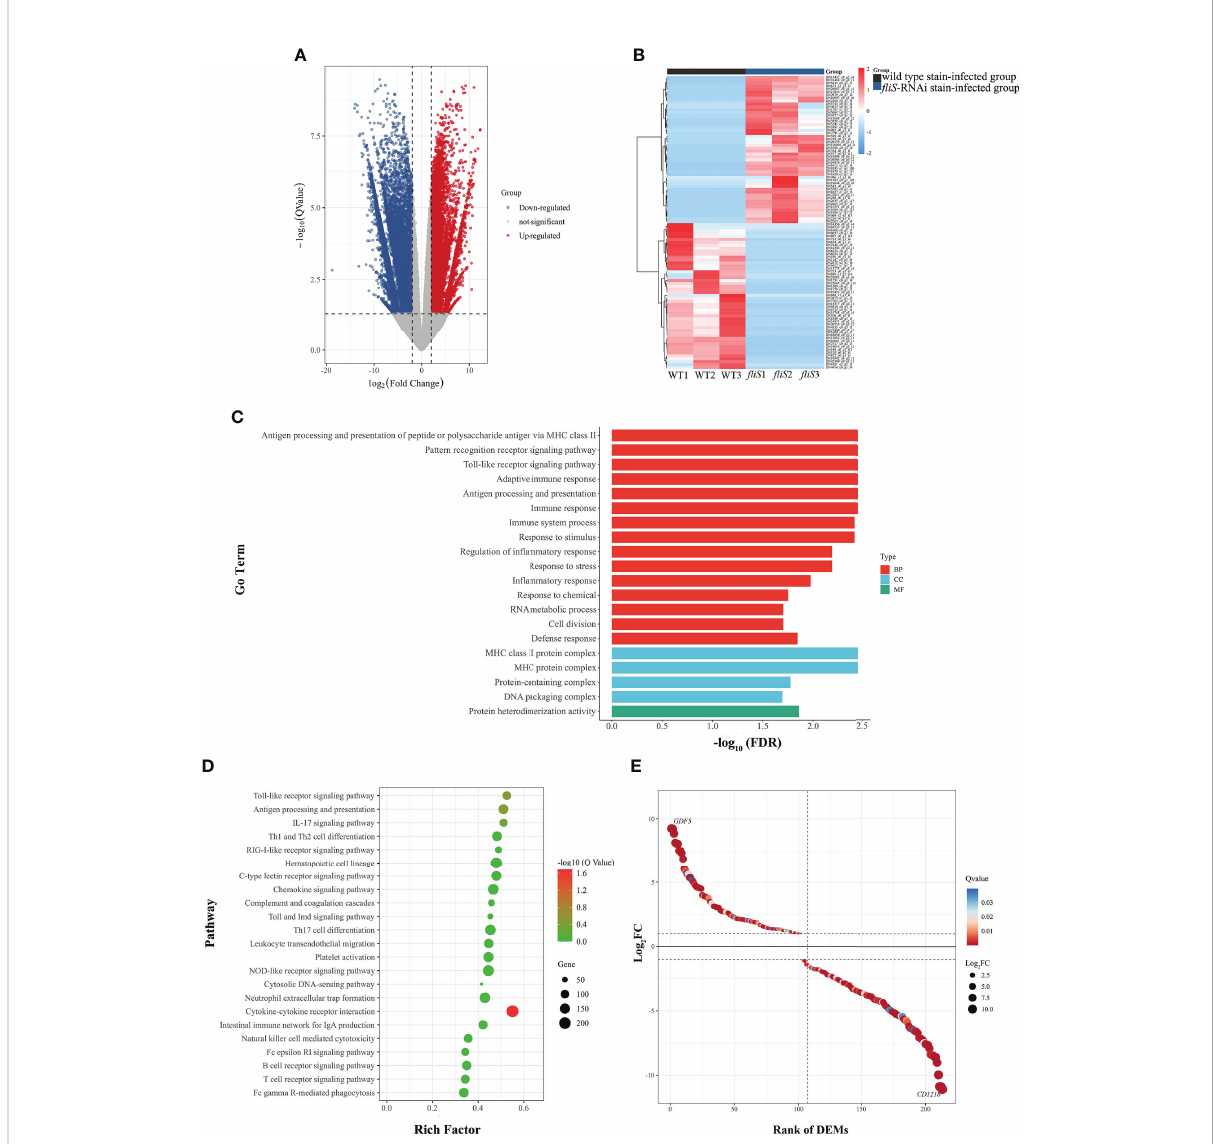
FIGURE 4 Comparative transcriptomic analysis of E coioides spleens infected by fl iS -RNAi and wild type strains of P. plecoglossicida . (A) Volcano plot obtained from EdgeR analysis. (B) Heat map of top 50 up-regulated (red) and down-regulated DEGs (blue). Deeper color indicates higher expression difference. (C) GO enrichment analysis of DEGs. (D) KEGG pathway enrichment analysis of DEGs. (E) Expression level of DEGs in cytokine-cytokine receptor interaction